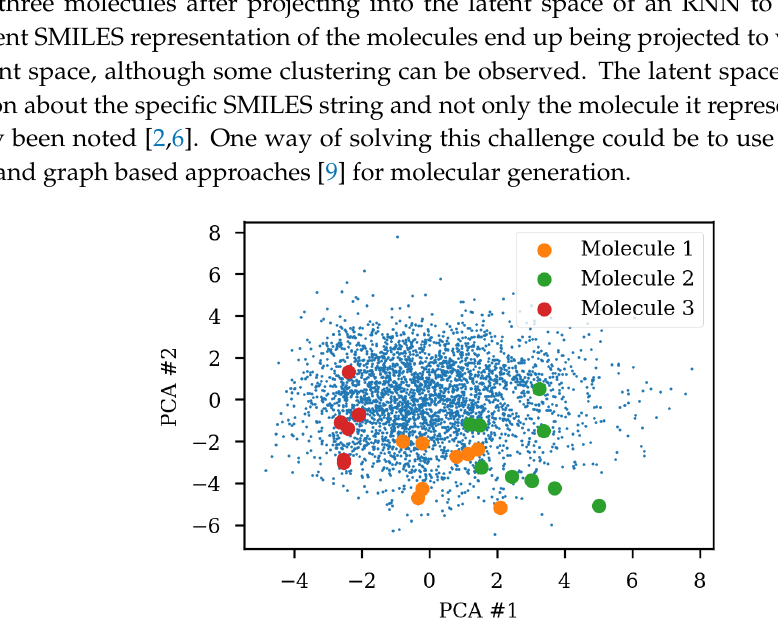
Figure 1. Enumeration challenge of a sequence to sequence model trained on canonical SMILES (simplified molecular-input line-entry system). The non-canonical SMILES of the same molecule is projected to different parts of the latent space reduced to two dimensions with principal components analysis (PCA). The small blue dots are the test set used for fitting the PCA. Some clustering of the enumerated SMILES can be